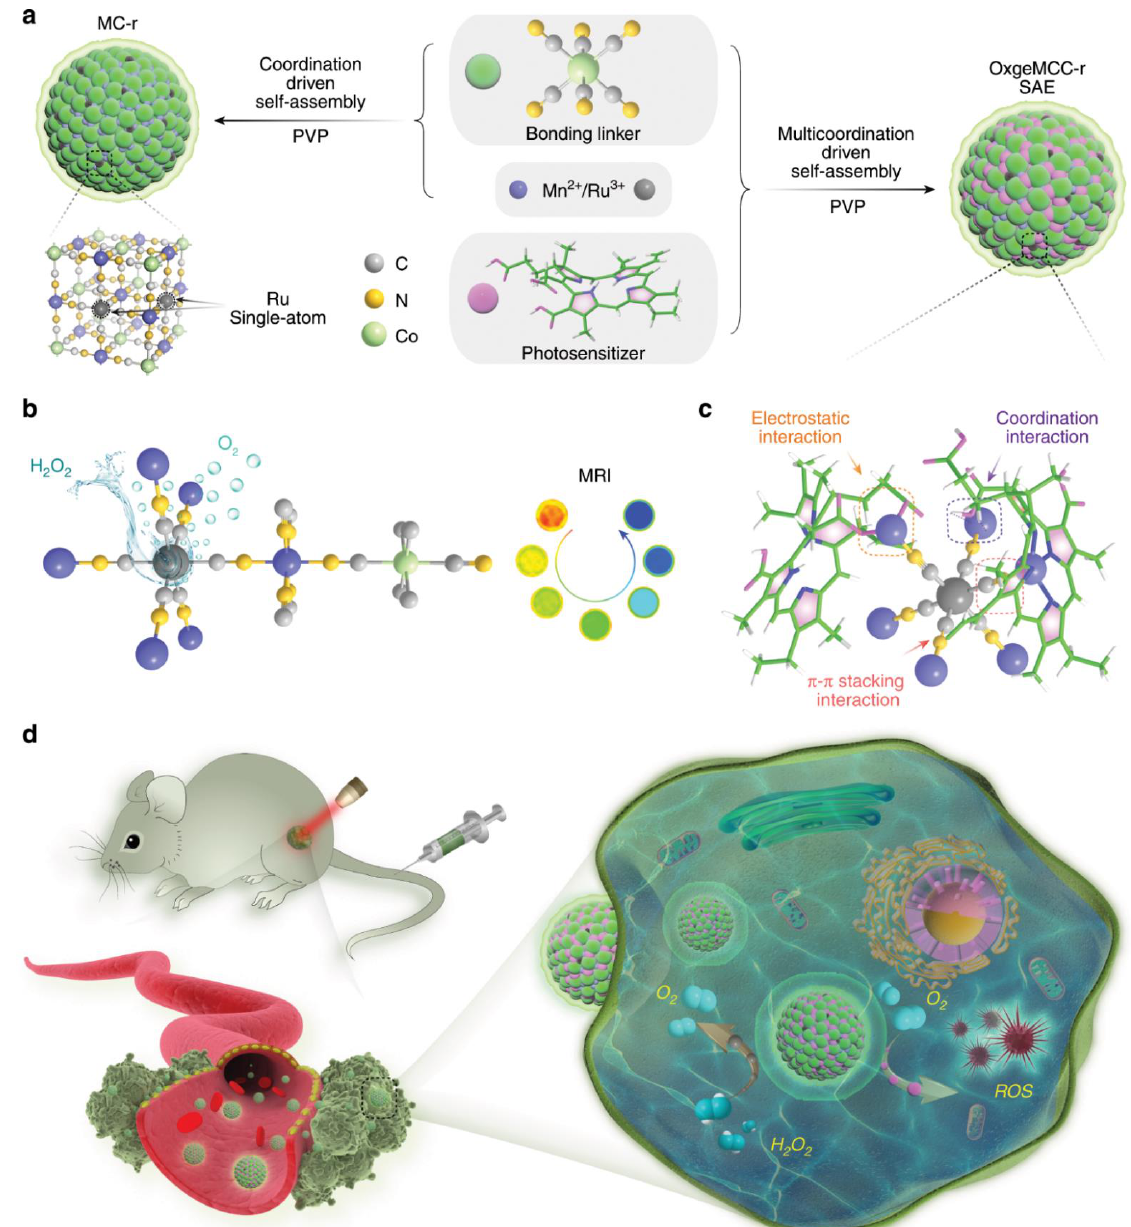
Figure 7. Schematic illustration of Ce 6 loaded Ruthenium incorporated metal organic framework-based single atom nanozyme (OxgeMCC-r SAE) in PDT. ( a ) Schematic representation of the fabrication of Ru-based single atom nanozyme. ( b , c ) are molecular structure and H 2 O 2 decomposition mechanisms of Ru-based nanozyme. ( d ) Schematic representation of in vivo ROS mediated catalytic therapy on OxgeMCC-r SAE. Image was reproduced with permission from reference [112].